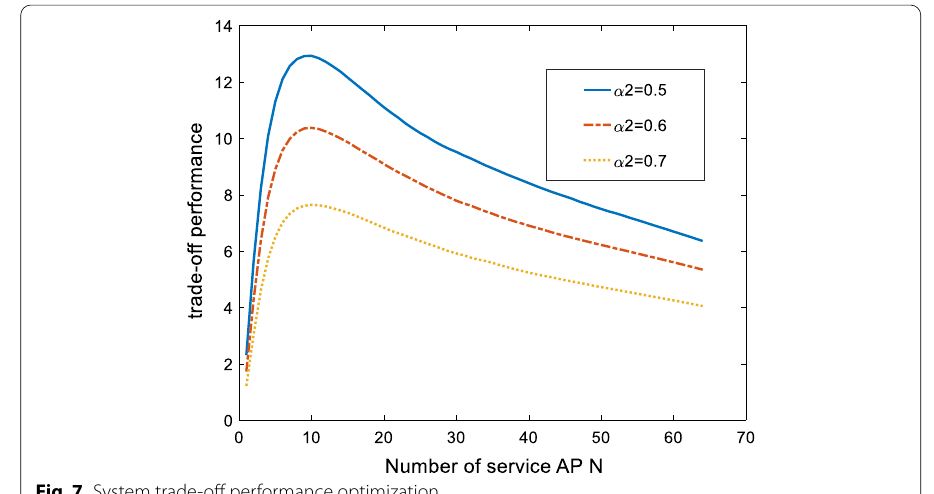
Fig. 7 System trade-off performance optimization